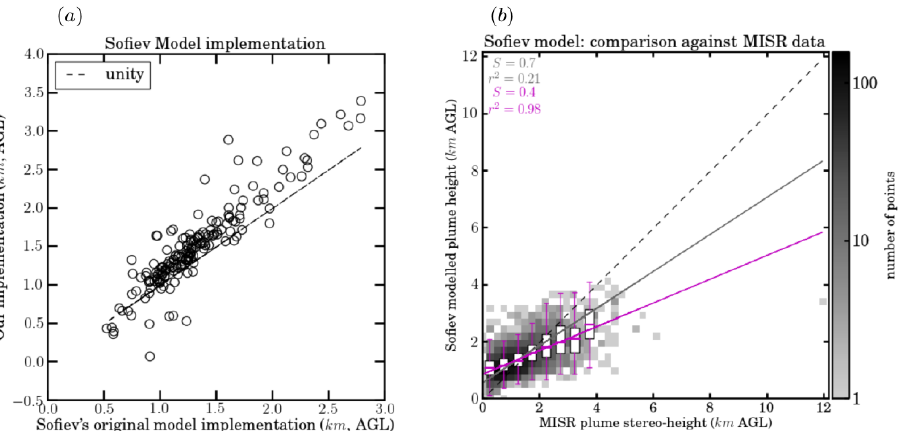
Figure 7. Comparison of our implementation of the plume rise parameterization of Sofiev et al. (2012) to (a) the original results from Sofiev et al. (2012) for the same fires and (b) plume stereo-height retrievals extracted from the North American subset of the (MISR) plume height project data Nelson et al. (2013), derived using the MINX tool as shown in Fig. 4. Our implementation of the Sofiev et al. (2012) model differs from the original in its definition of the PBL height, which in our approach is extracted from the diagnostic product of ECMWF forecast runs (ECMWF, 2012). See Figs. 9 and 10 for a statistical overview of the North American MISR data set. Note that the Sofiev et al. (2012) model did not retrieve simulated plume heights for all the 3320 selected fires of that data set. For 114 fires, either the Brunt–Väisälä frequency could not be retrieved or the FRP of the most powerful pixel listed in the MISR product was unavailable (see Sofiev et al., 2012, for details in the initialization of the model). Panel (b) shows the same metrics as Fig. 2 of Val Martin et al. (2012), i.e. two-sided regression line (grey), box plots of the distributions of model heights and 500m resolution MISR heights for central 67% (box) and central 90% (cap), median distribution regression line (magenta), and 1 : 1 relationship (dashed